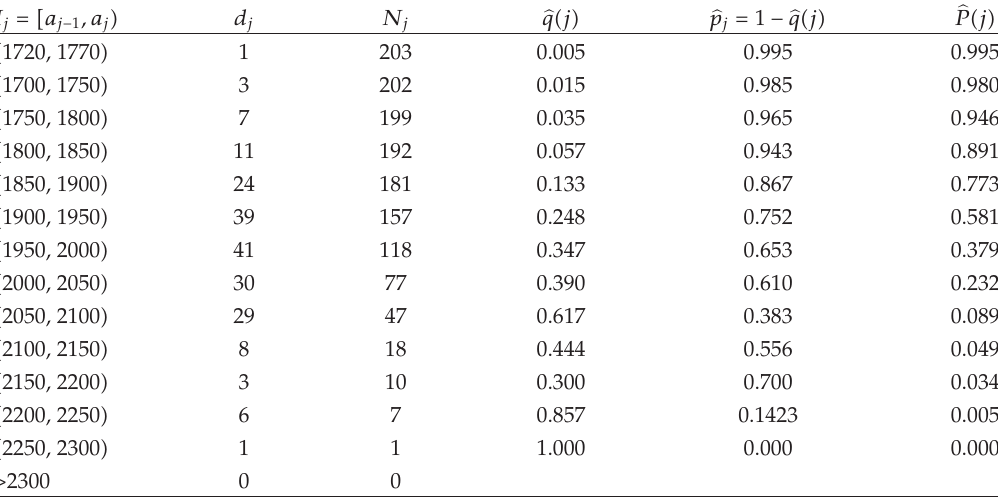
Table 7: Estimation result of the capacity distribution for the median lane.